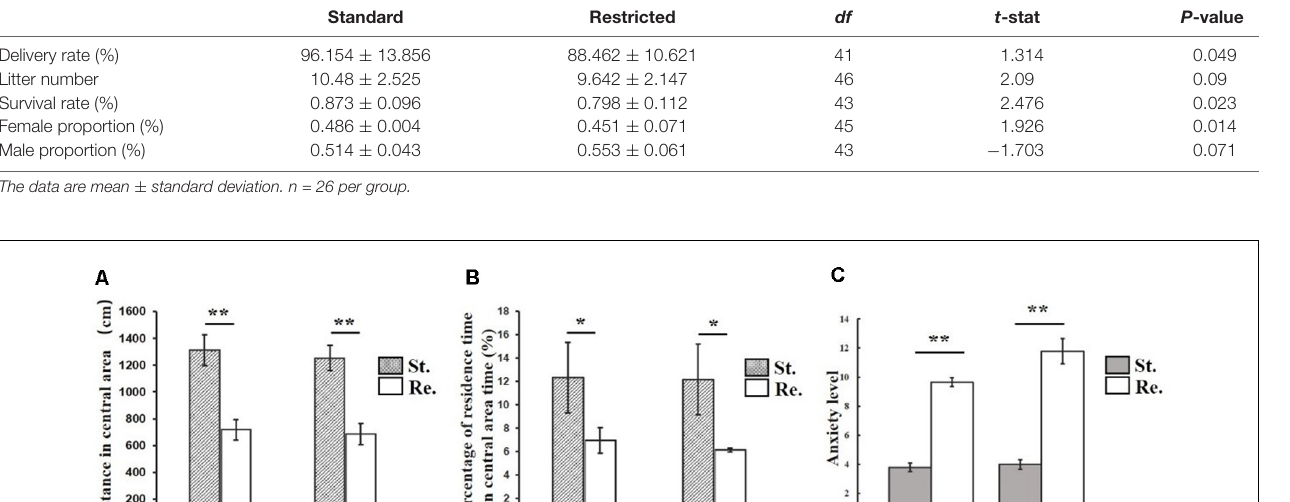
TABLE 1 | Reproductive capacity of mice in both cages. Standard Restricted df t -stat P -value Delivery rate (%) 96.154 ± 13.856